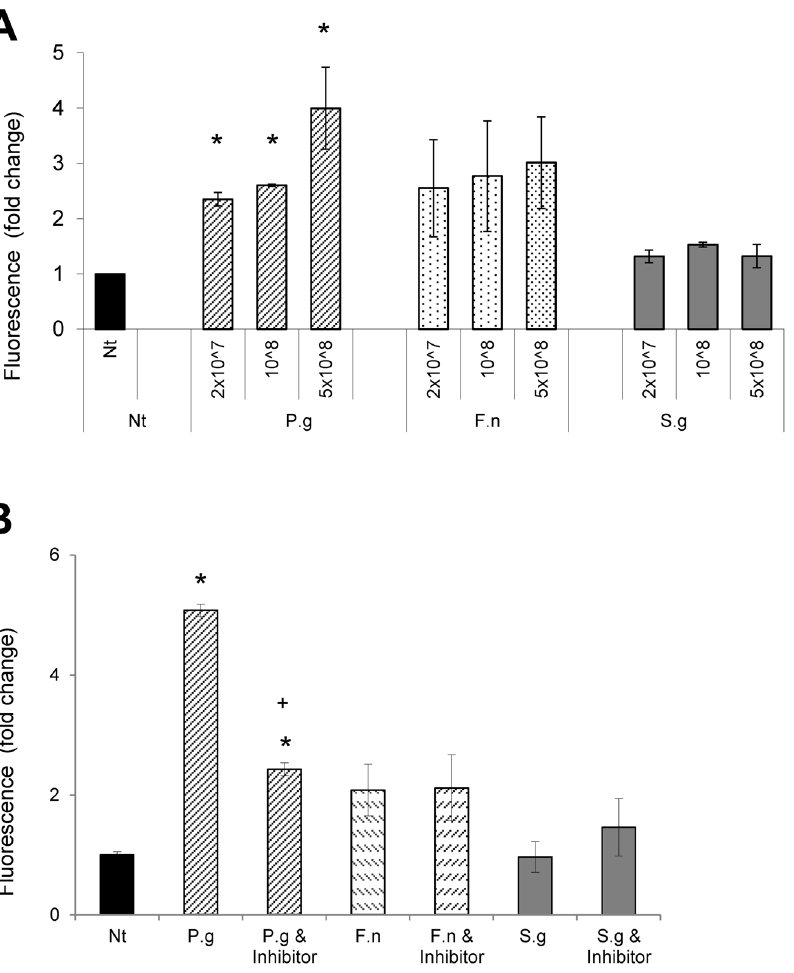
Figure 1. P.gingivalis but not F.nucleatum or S.gordonii induces loss of barrier function. P. gingivalis , F. nucleatum and S. gordonii were tested for loss of barrier function with fluorescein isothiocyanate–dextran (FITC-Dextran) with multi-layer, differentiated primary human gingival epithelial cells induced by air-liquid interface. A: Bacterial dose response. B: Incubation with the protease inhibitor leupeptin (100 m M). * Significantly different from matched control (P , 0.05). + Significantly inhibited by leupeptin (P , 0.05).